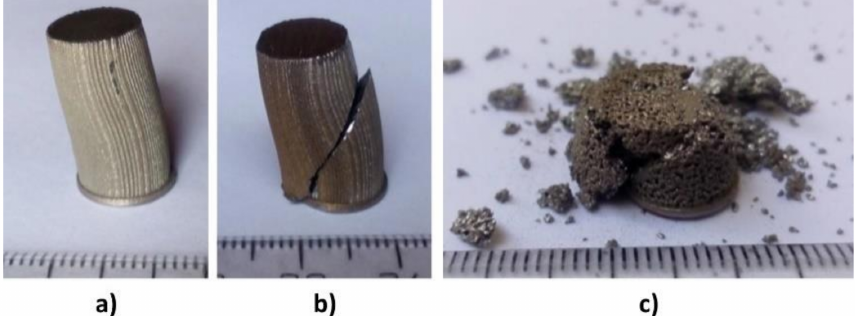
Figure 10. The resulting deformations of samples after pressure testing: ( a ) bending, ( b ) fracturing, ( c )